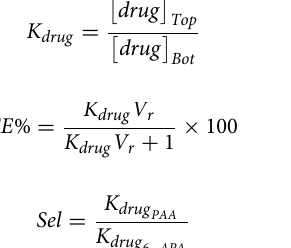
to determine biomolecule concentrations. In this work, the partition coefficient ( K drug ), the percentage extraction efficiency ( EE% ) and selectivity (Sel) were defined following Eqs. (8–10):